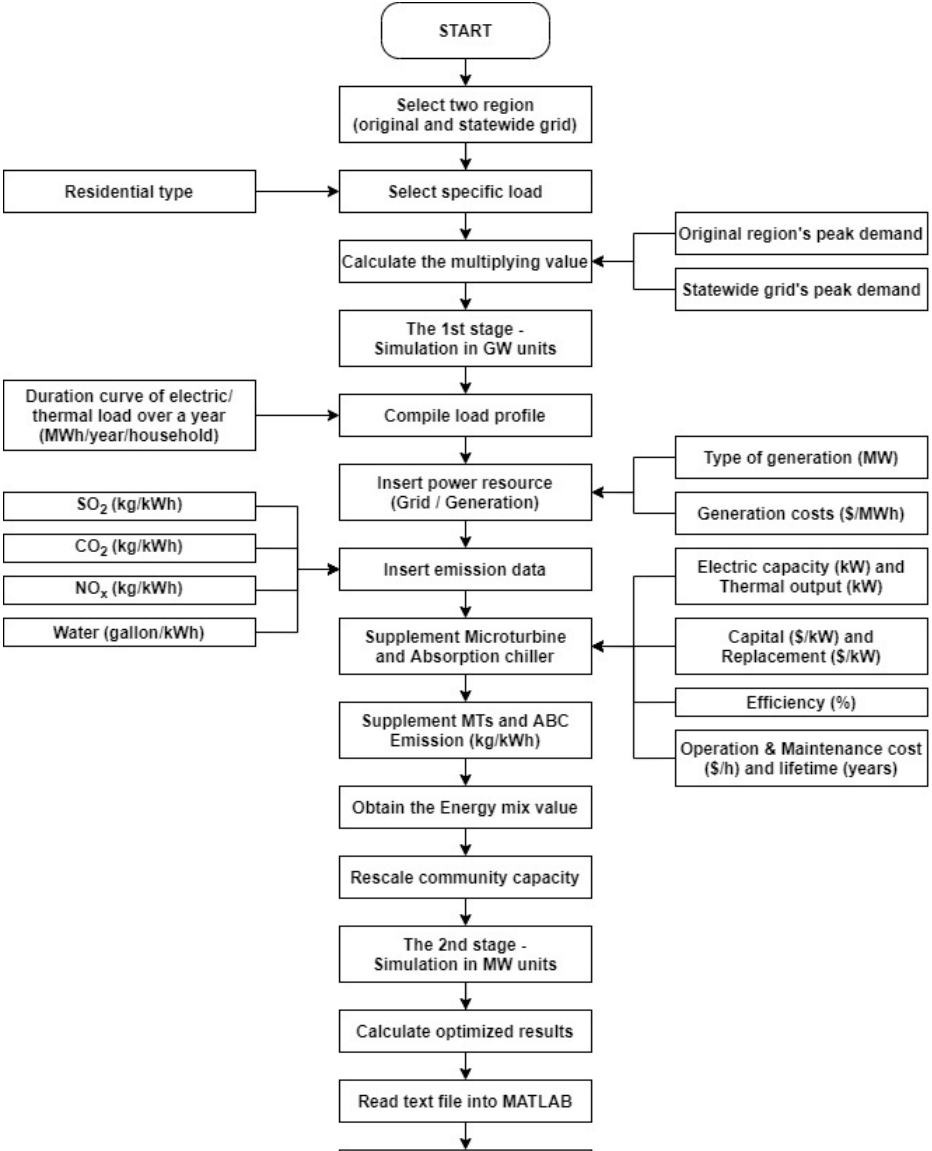
Figure 7. Proposed two-stage optimization process.